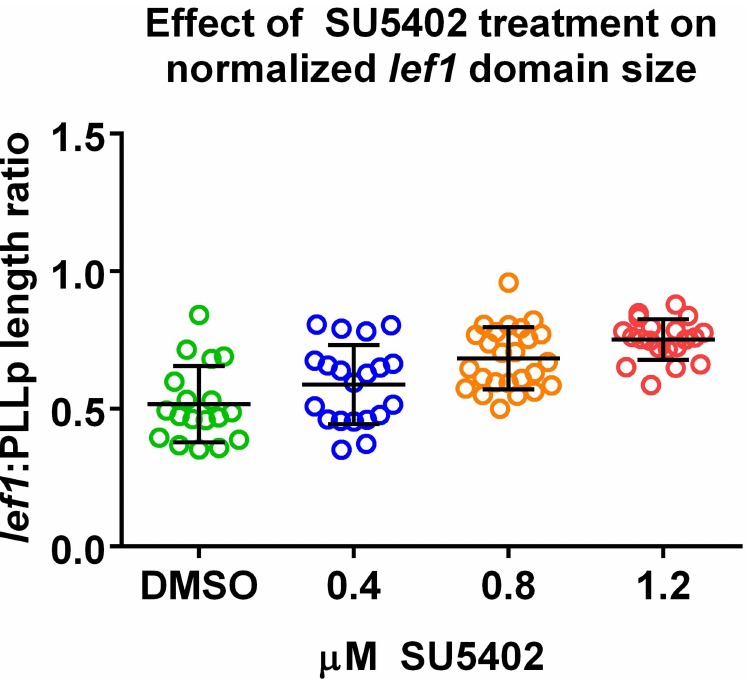
Fig 12. Dose response experiment using SU5402. The FGF receptor blockerSU5402increasesthe size of the WntR activity domain in a dose-dependentmanner( lef1 used as a marker). The size of the lef1 domain has been normalizedrelative to the size of the wholePLLP. A Linearregressionanalysisresultedin y = 0.2005 x + 0.515. A one-wayANOVA reveals that the slope is significantly non-zero(0.2005 ± 0.03012). The 95% confidenceinterval for the slope is 0.1405—0.2605, with R 2 = 0.3536, and P < 0.0001. These results validatethe findings of our model.